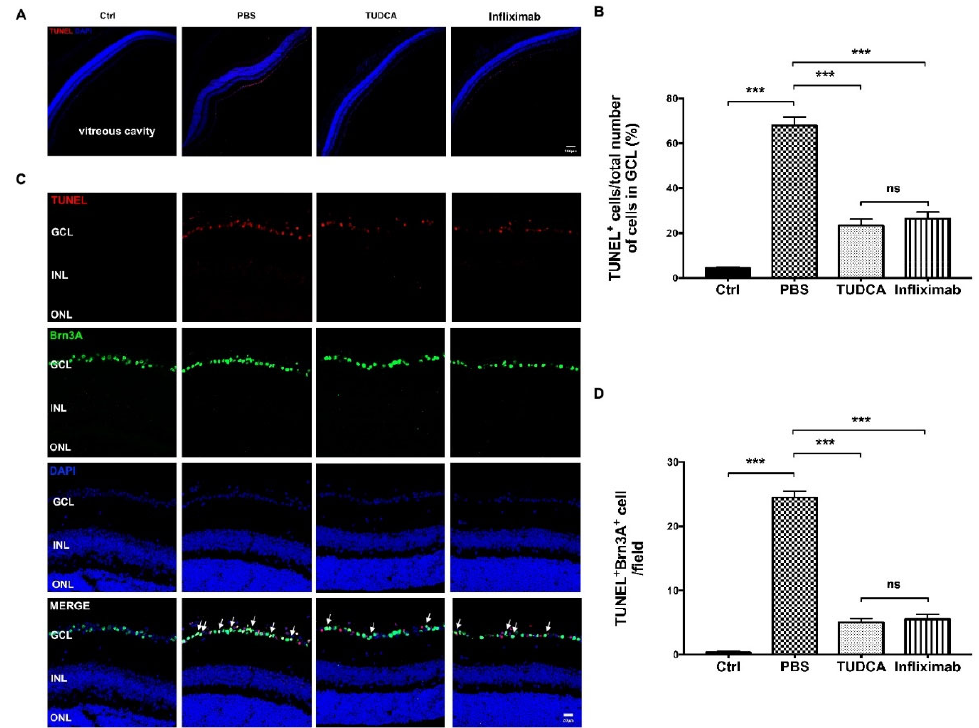
Figure 4. TUDCA attenuates RGC apoptosis after OAB. ( A ) Representative retinal cryosection images stained with TUNEL (red fluorescence) and DAPI (blue) in the control, OAB with PBS-treated, OAB with TUDCA-treated, and OAB with infliximab-treated groups at 1 day after OAB. Scale bar: 100 μ m. ( B ) The quantification of TUNEL labeling is calculated as the total number of red cells (TUNEL) divided by the total number of blue cells (DAPI) in the GCL layer, and then multiplied by 100 ( n = 8 regions/mouse of six mice). ( C ) Double immunofluorescence staining with TUNEL (red fluorescence) and the RGC marker Brn3A (green fluorescence) in different groups. Scale bar: 20 μ m. ( D ) Quantitative analysis of TUNEL + Brn3A + cells in each retina area ( n = 6 mice/group). Data are expressed as mean ± SEM (*** p < 0.001; ns, no significance). Ctrl, control; OAB, ocular alkali burn; GCL, ganglion cell layer; TUDCA, tauroursodeoxycholic